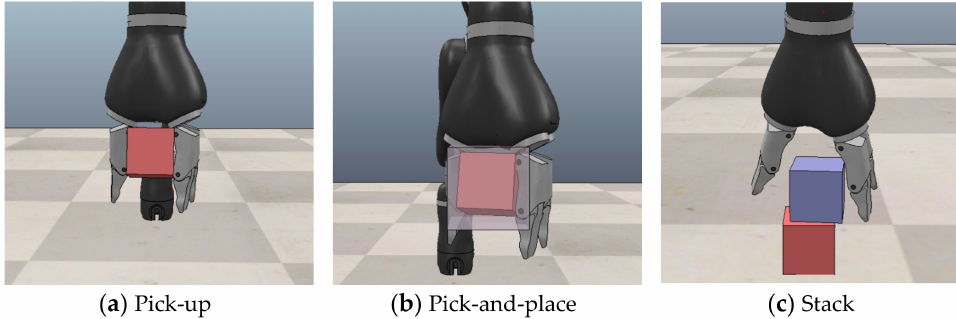
Figure 5. Three robotic manipulation